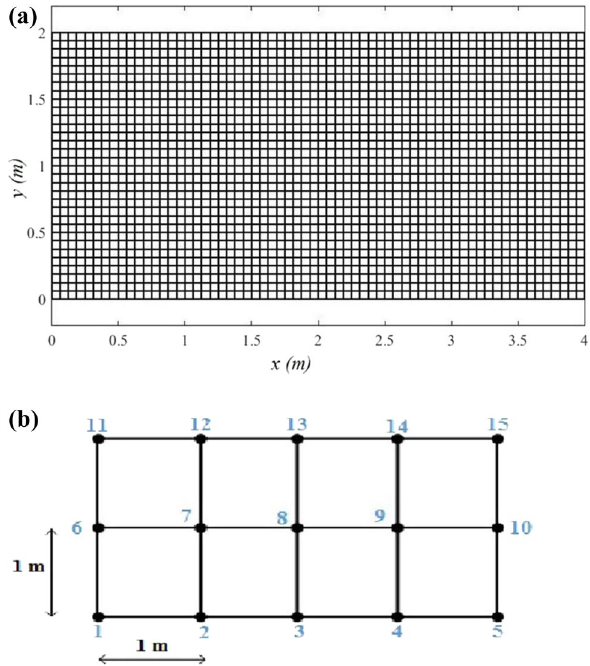
Fig. 3 Meshed domain with a 2048 elements, b 8-element with nodes number for validation